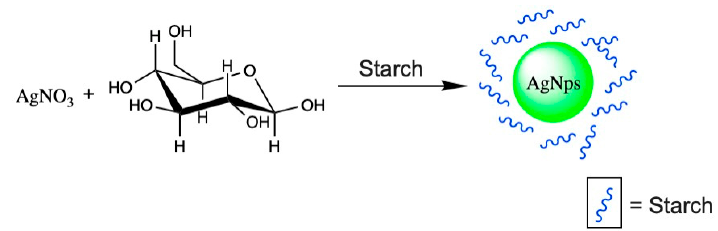
Figure 4. Chemical reduction of AgNO3 salt from β -D-glucose.